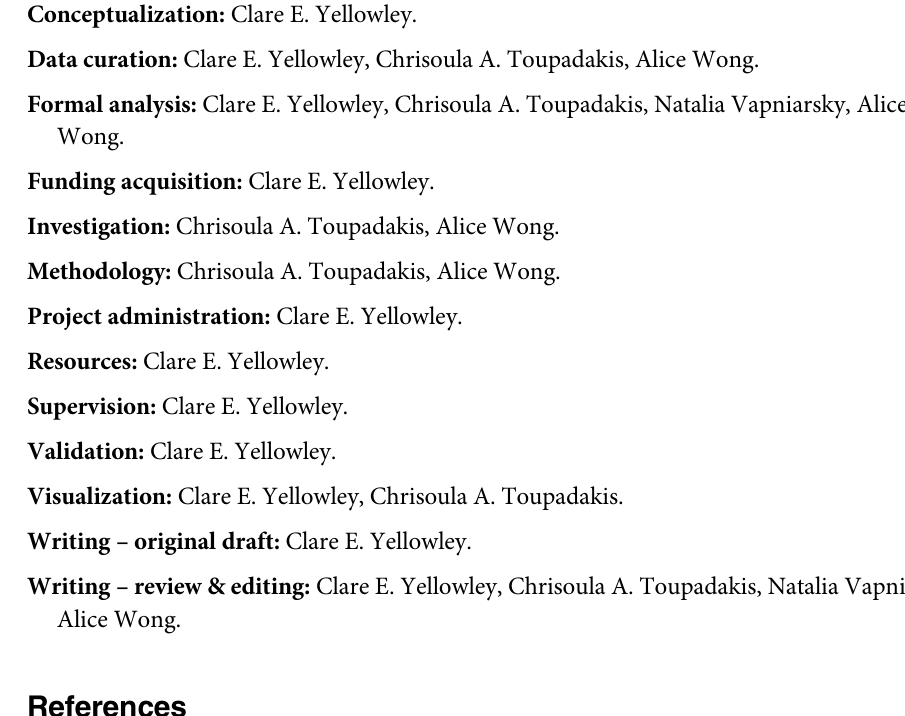
S1 Fig. Circulating neutrophil, basophil and monocyte cell numbers. Neutrophil, basophil and monocyte counts (Advia 120) from wounded mice at time points between 0 and 48hrs. Bars represent mean ± SEM, n = 2–8 indicated in brackets below each bar.